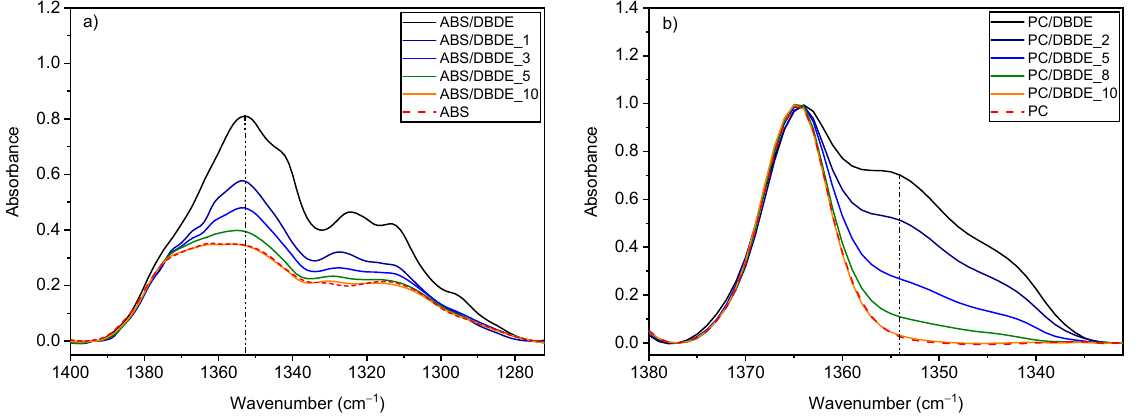
Figure 2. FTIR spectra of ( a ) 90 wt-% ABS/10 wt-% DBDE and ( b ) 90 wt-% PC/10 wt-% DBDE films: Evolution of the ether band of DBDE at 1350 cm − 1 as function of irradiation time given in minutes. The bands at 966 cm − 1 and 911 cm − 1 , attributed to the vinyl stretching of the butadiene component, can be regarded as the most fragile part of the ABS chain [42]. The band at 966 cm − 1 showed a rather linear decrease as a function of irradiation time; however, this was small when compared to the decrease in the 1350 cm − 1 band, which stabilized after a certain irradiation time as can be observed in Figure 3. It should be mentioned that the absorbance at 1350 cm − 1 was not expected to fall below a certain value in the irradiated ABS/DBDE blends since the virgin ABS presents a specific absorbance around this wavenumber as can be seen in Figure 2a. In the case of the PC (Figure 2b), the disappearance of the shoulder at 1350 cm − 1 was rather complete after 10 min of exposure time with no visible change in the other bands.